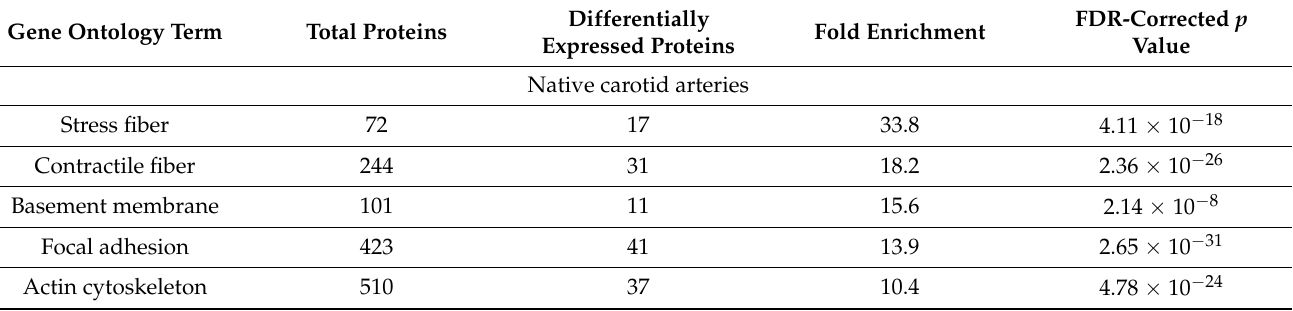
Table 2. Distribution of proteins which are upregulated in either native carotid arteries or TEVGs across various cellular compartments (annotated according to the Gene Ontology Cellular Compo- nent database).